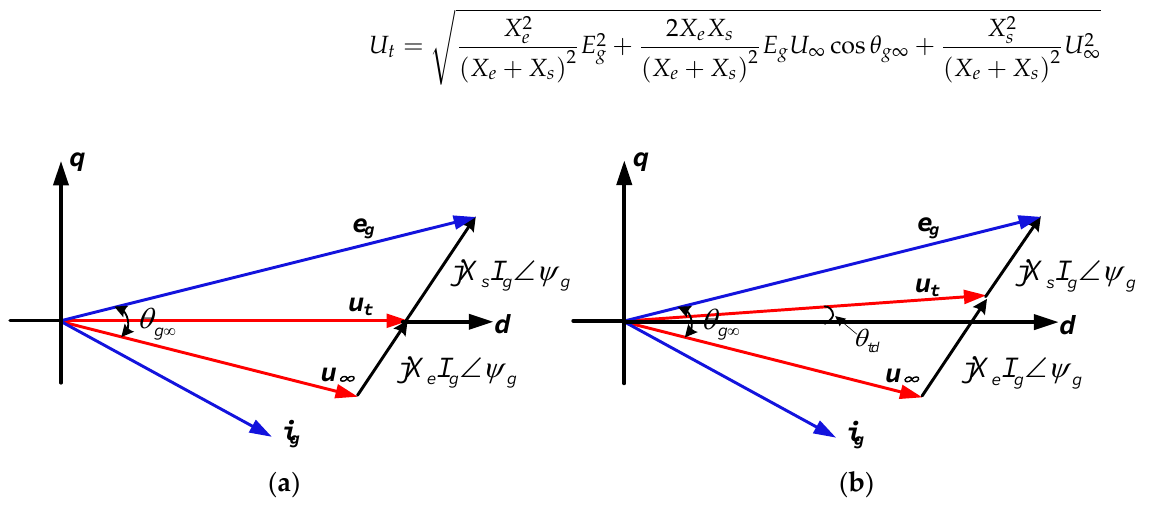
Figure 3. Four-vector diagram for synchronverter control dynamics: ( a ) steady state; ( b ) transient state during a disturbance.